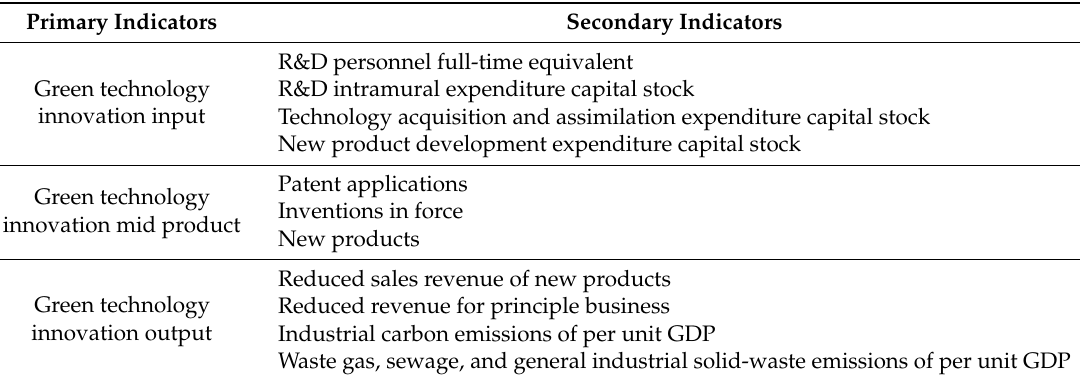
Table 1. The two stages of industrial enterprises’ green innovation indicators with shared